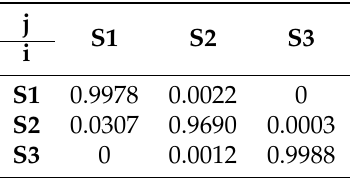
Table 1. Example of a transition matrix for a washing machine.